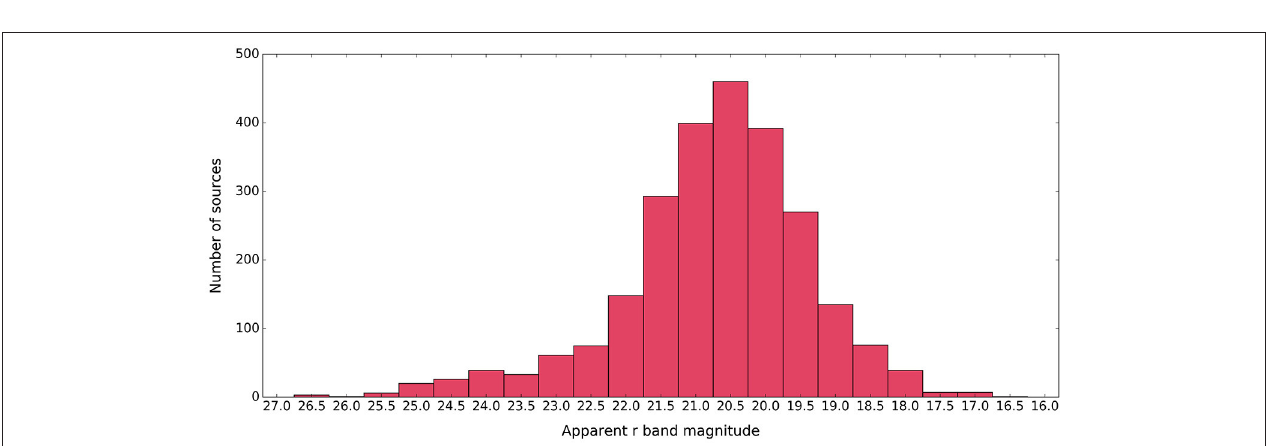
FIGURE 3 | Apparent red magnitude distribution of the high-redshift AGN. The histogram shows the 2,493 sources with available red magnitudes with a bin width of 0.5 m . Note that since most sources have photometry based on POSS plates, magnitudes might differ from SDSS magnitudes, up to 2 m − 3 m